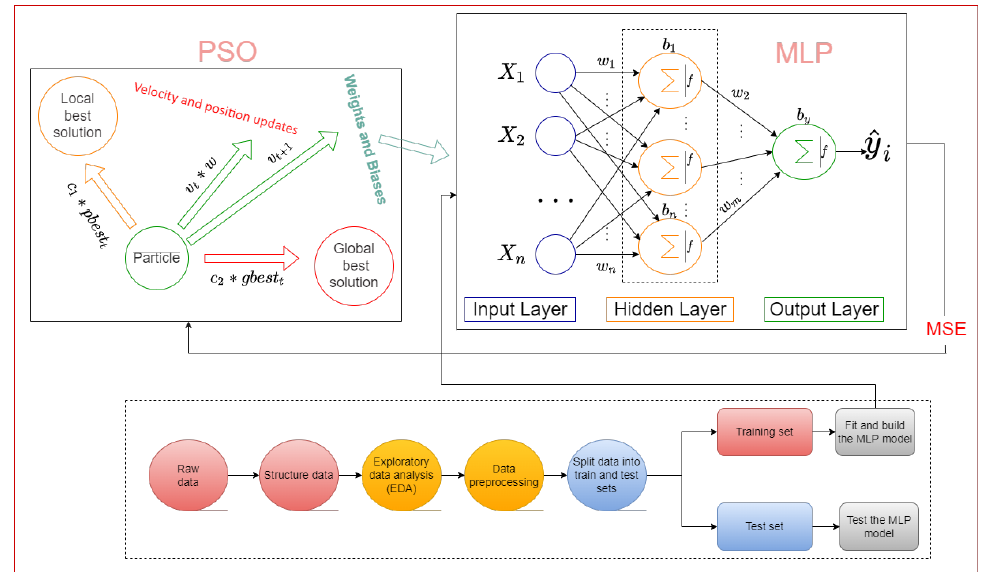
Figure 7. Schematic diagram of the proposed MLP-PSO model for heart disease